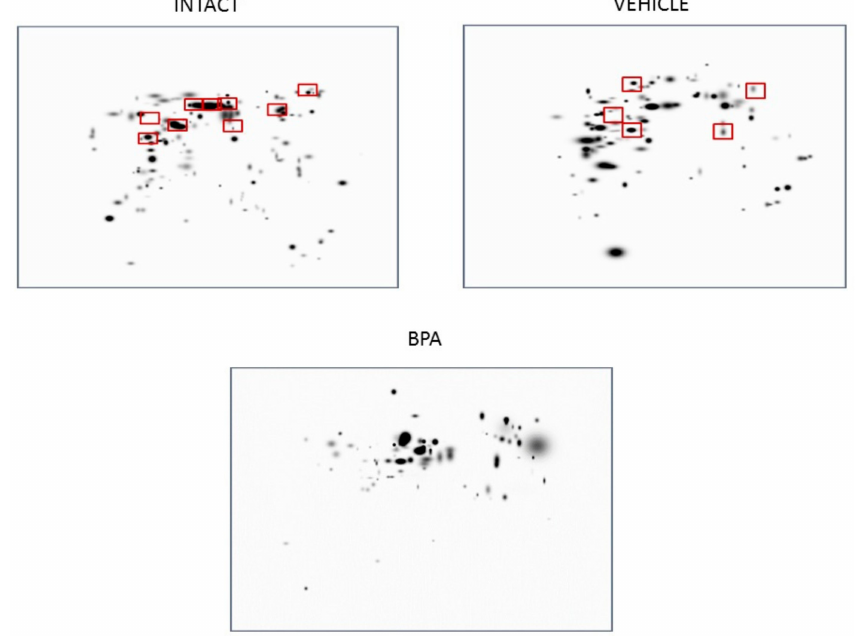
Figure 3. 2D master images obtained from average images of mice in each experimental situation. Control: N = 6, Vehicle: N = 4 and BPA: N = 7. The red boxes indicate the spots that are common to all the mice in that